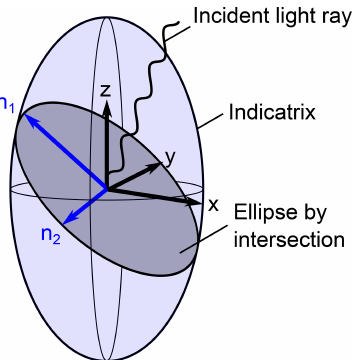
Figure 2. Indicatrix as an analogy to describe two indices of refrac- tion for a certain direction of incident light in a birefringent mate-